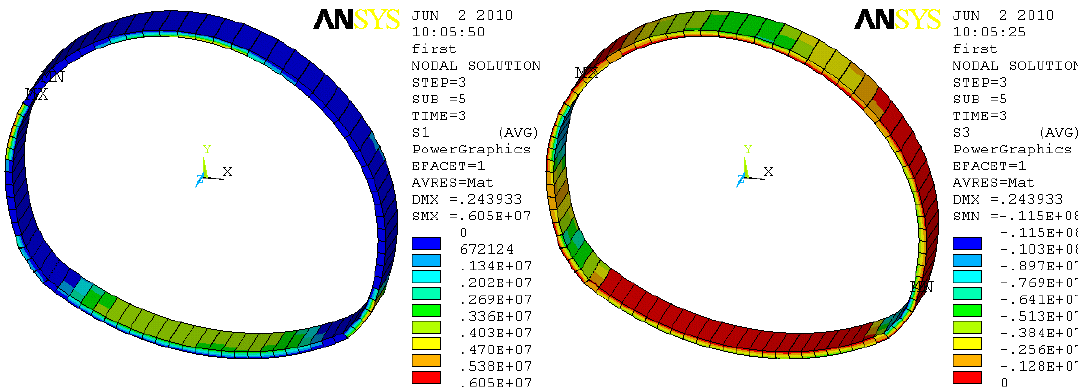
Fig. 5 Supporting the first principal stress and supporting the third principal stress